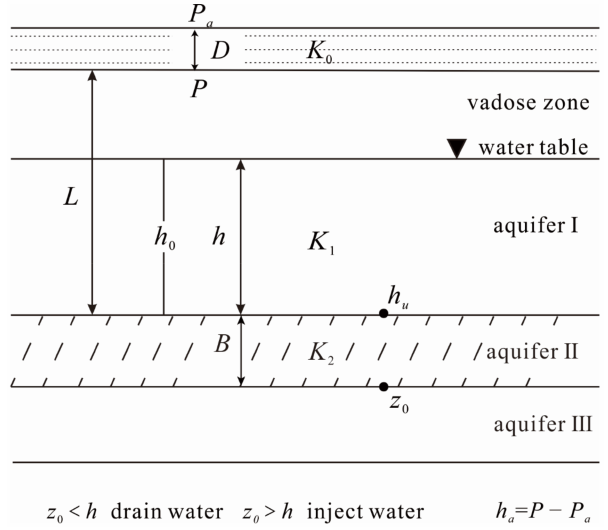
Figure 1. Conceptual model for coupling of air flow and water flow in the vadose